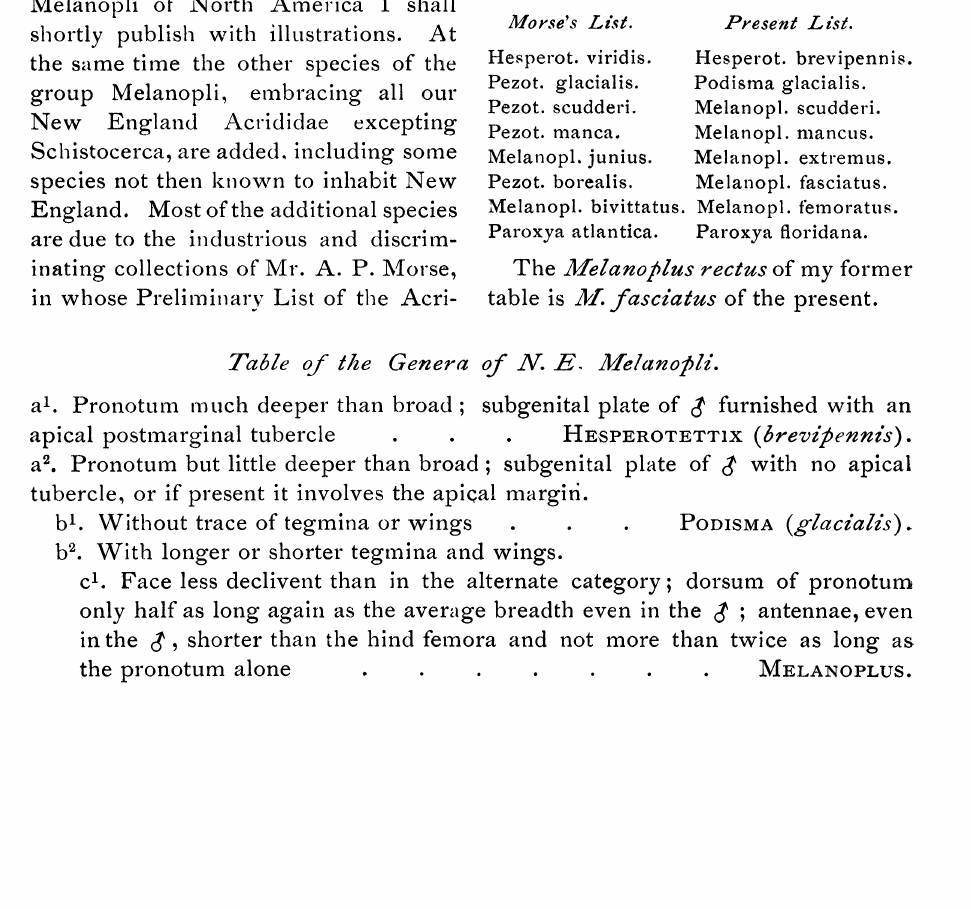
Table of the Genera of iV.